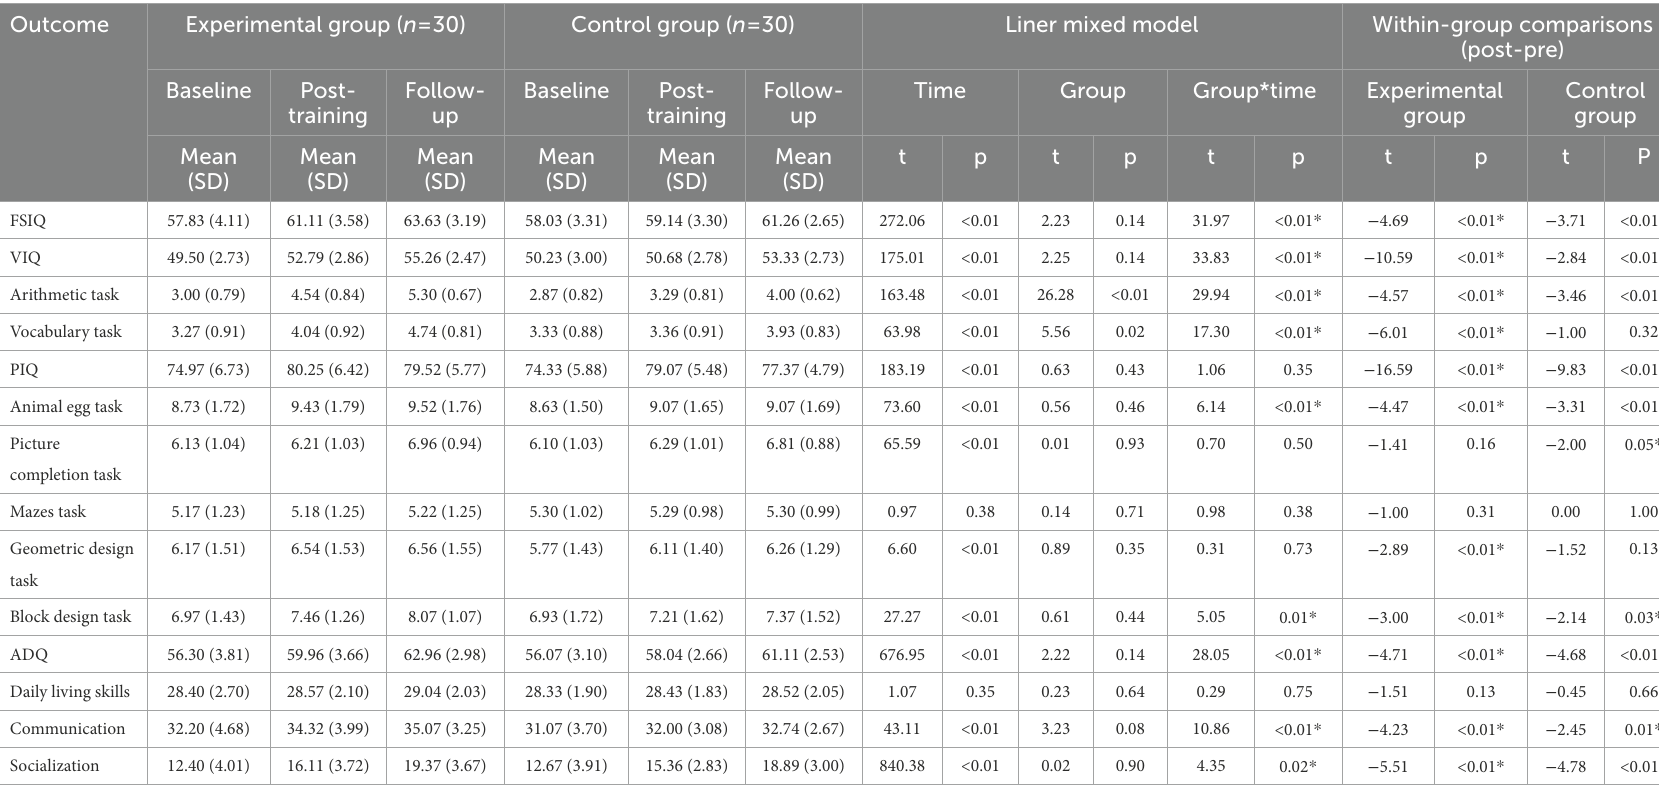
TABLE 2 Summary of results of mixed linear model analyses on score of different clinical outcome measures of participants in the multi-domain computerized cognitive training group (Experimental group) and multi-domain traditional cognitive training group (Control group) for the baseline, post-training, and 3-month follow-up assessment occasions. Outcome Experimental group ( n = 30) Control group ( n = 30) Liner mixed model Within-group comparisons Baseline Post- Follow- Baseline Post- Follow- Time Group Group*time Experimental training up training up